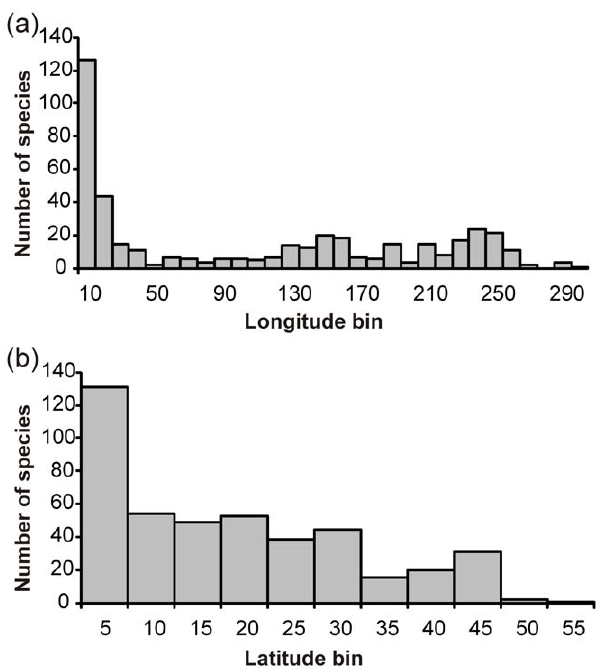
Figure 4. Latitudinal and longitudinal range sizes of sponge species found at three or more locations in the Southern Ocean and neighbouring regions. (a) Longitudinal range and (b) is the latitudinal range. Range size is the difference between the maximum and minimum range points and does not imply that the organism is found everywhere